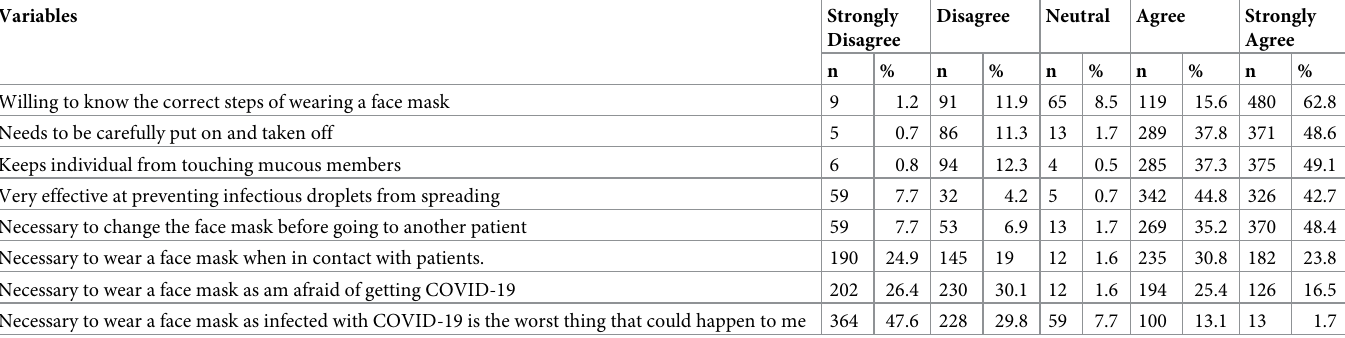
Table 3. Attitude-related questioner on knowledge, attitudes, and practices of face mask utilization and associated factors in COVID-19 pandemic among Wachemo university students, southern Ethiopia: February to March 2021 (n = 764).